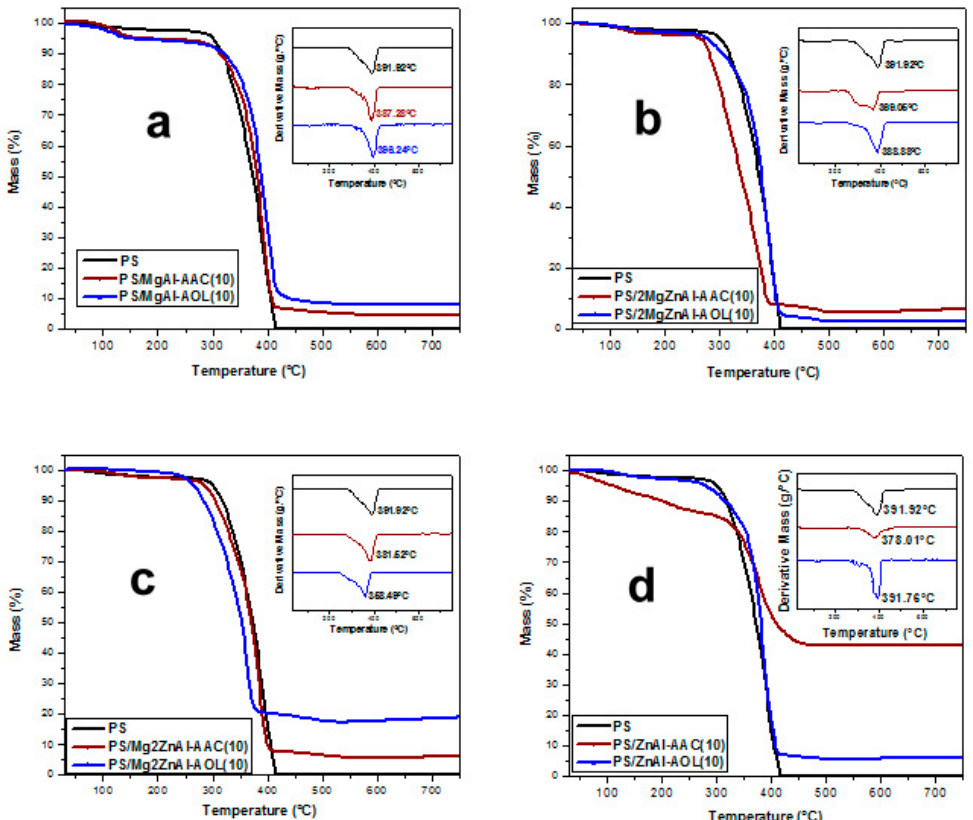
Figure 9. Thermograms for nanocomposites with 10 wt.% of LDH modified with acrylate (AAC) and oleate (AOL) anions for: ( a ) MgAl, ( b ) 2MgZnAl, ( c ) Mg2ZnAl, and ( d ) ZnAl.